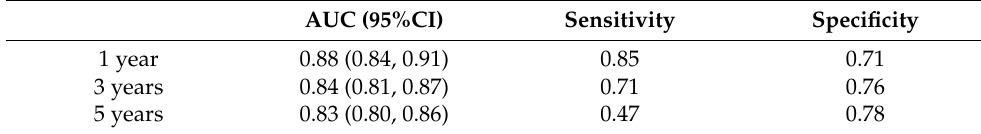
Table 3. Model performance in the testing